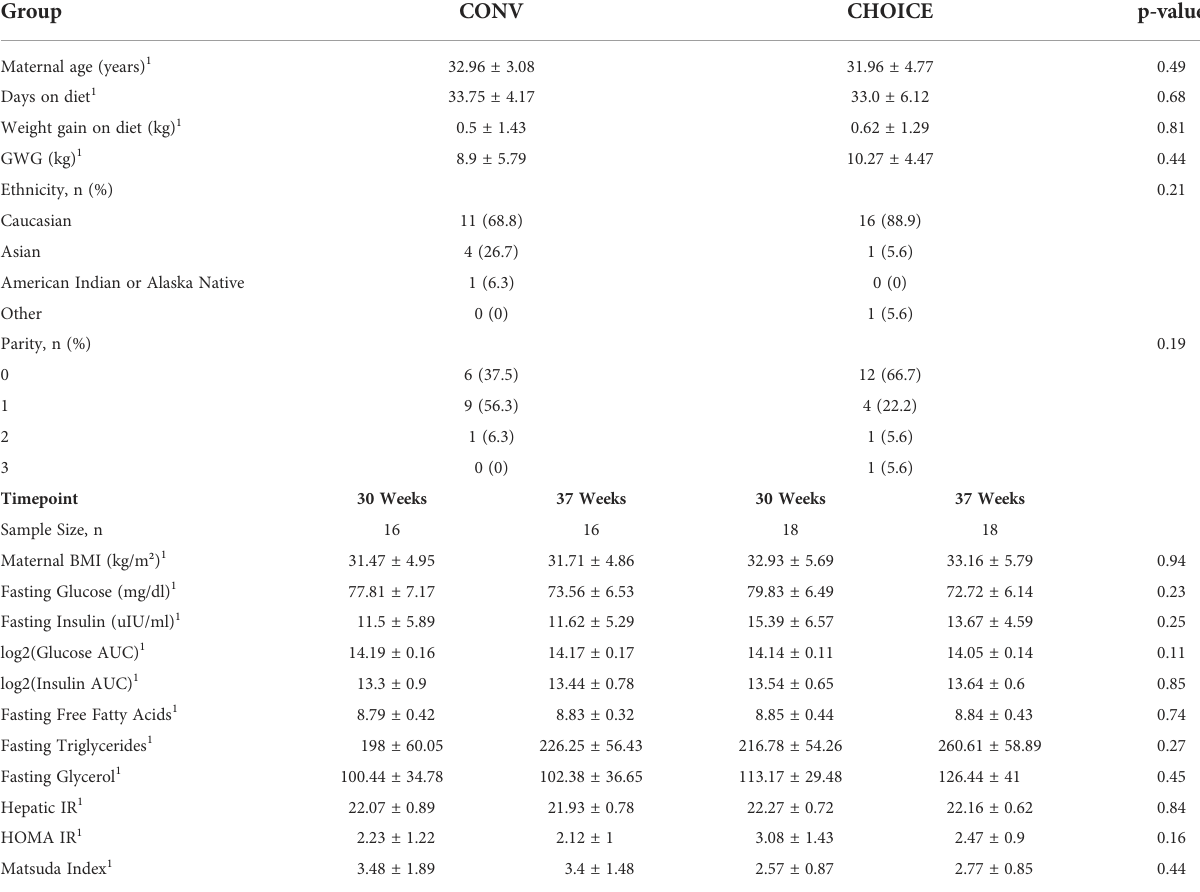
TABLE 1 Maternal population characteristics.